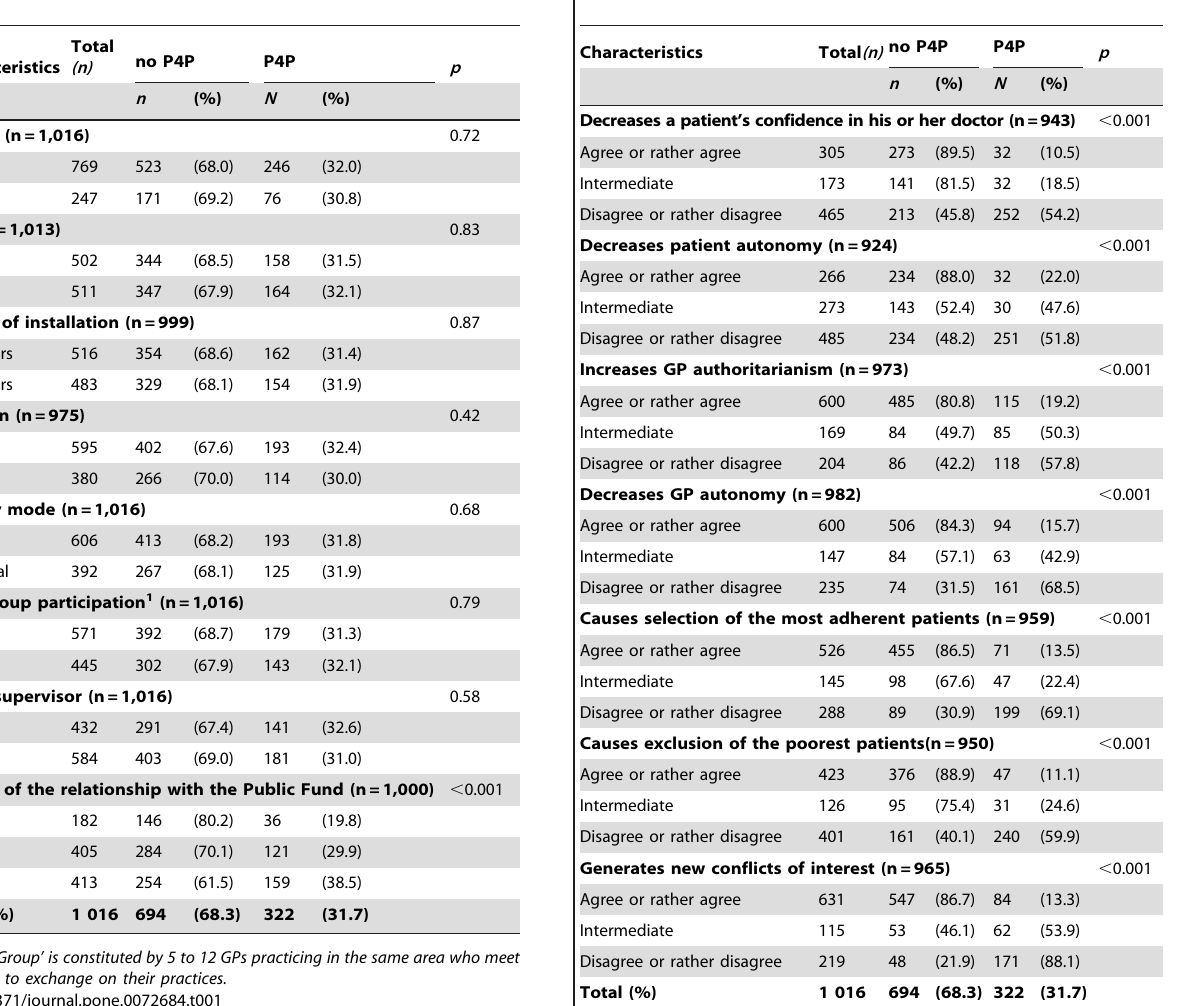
Table 1. Description of the sample in terms of socio demographic characteristics (n=1.016).